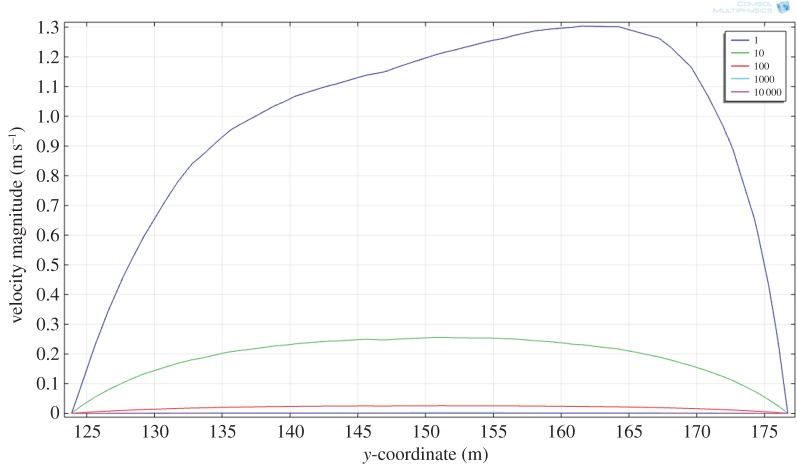
Effects of increasing melt viscosity on the cross-sectional (y-coordinate) flow velocity taken at the same mid-point of the Sill (x = 120, figure 6). Velocities range from approximately 1.3 m s−1 (viscosity 1 Pa s) to 3 × 10−4 m s−1 (viscosity 104 Pa s).